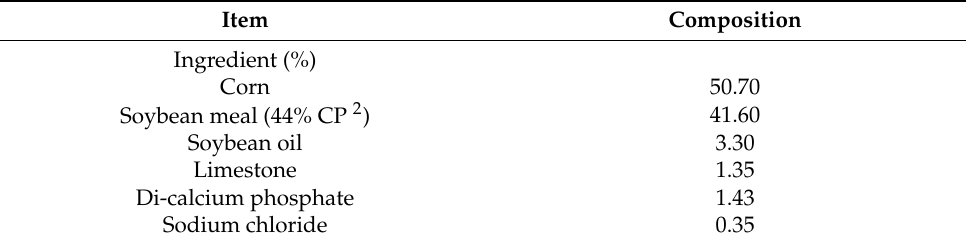
Table 1. Ingredient composition of experimental diet 1 (as-fed